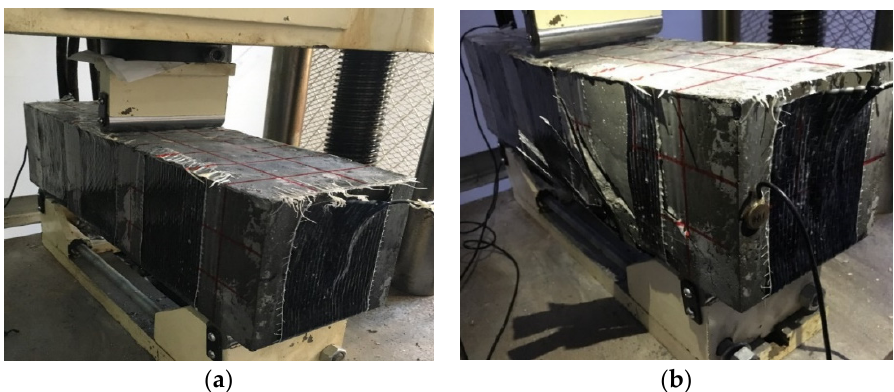
Figure 19. Test procedure ( a ) initial condition ( b ) collapse at load of 139.8 kN.